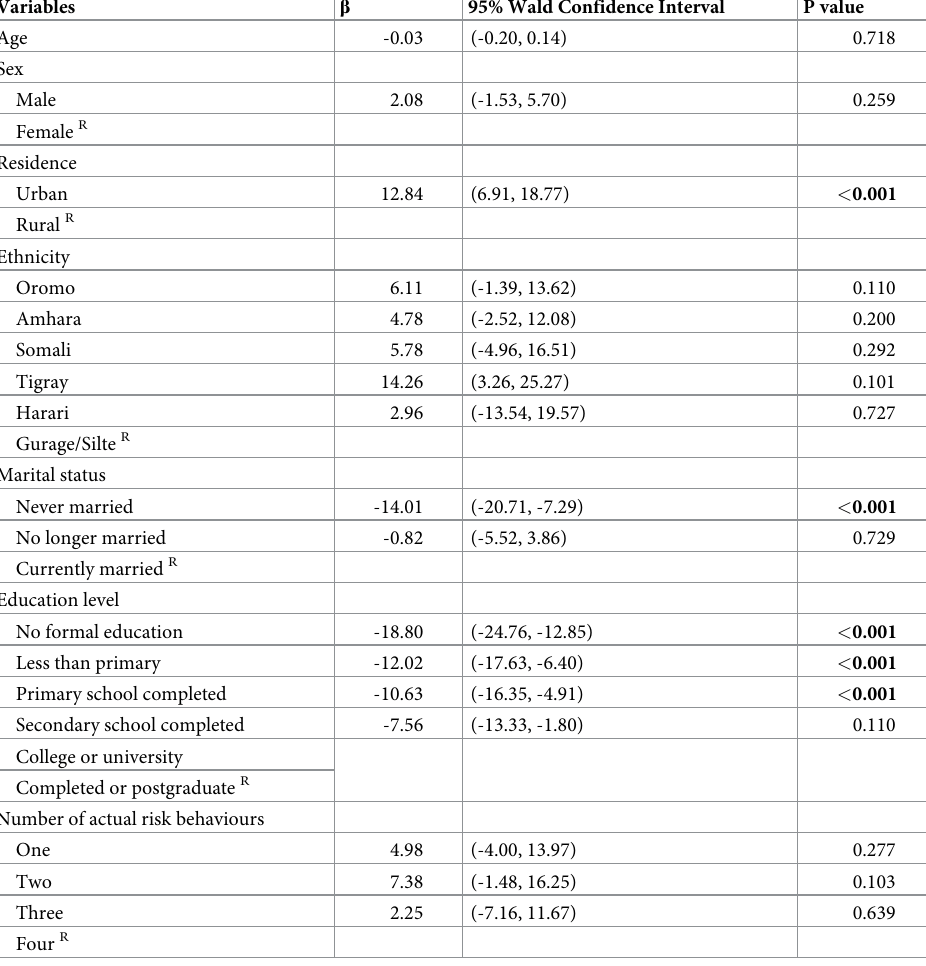
Table 4. Multivariable analysis of potential associations of CV risk factors knowledge with health behaviour and sociodemographic variables in eastern Ethiopia,